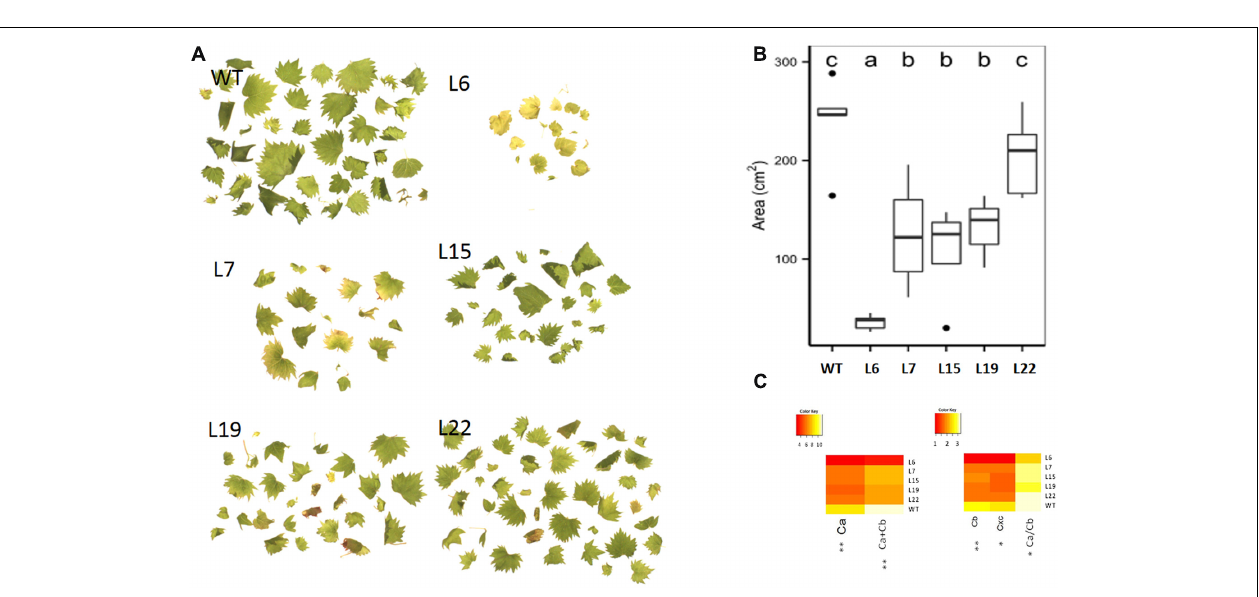
FIGURE 2 | Characterization of VviERF045 overexpressing lines. (A) Relative expression level of the endogenous + exogenous gene (blue bars), and endogenous gene (orange bars) in the transgenic lines. Error bars are based on data from three biological and two technical replicates. Data were normalized using ubiquitin and actin as reference genes. Relative expressions with the same letter are not significantly different ( p < 0.05) according to Tuckey’s post hoc test. The ANOVA test refers to the red bars since for blue bars no significant difference was observed. (B) In vitro phenotype of transgenic and WT plants of the same age.